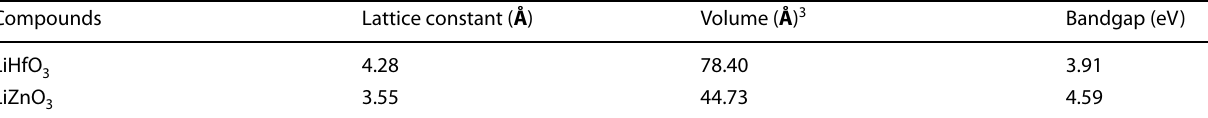
and LiZnO lattice constants, volume, and bandgap 3 3